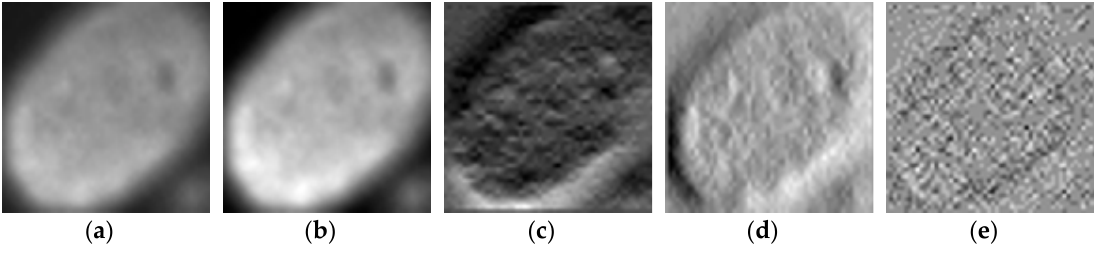
Figure 3. Positive intensity Fine Speckled cell. ( a ) Original image; ( b ) the approximation; ( c ) the horizontal detail; ( d ) the vertical detail; and ( e ) the diagonal detail. The original image has a size of 112 × 112. The outputs of the DWT are all downsized by half (56 × 56). All the images in the figure were identically resized for the purpose of visualization.